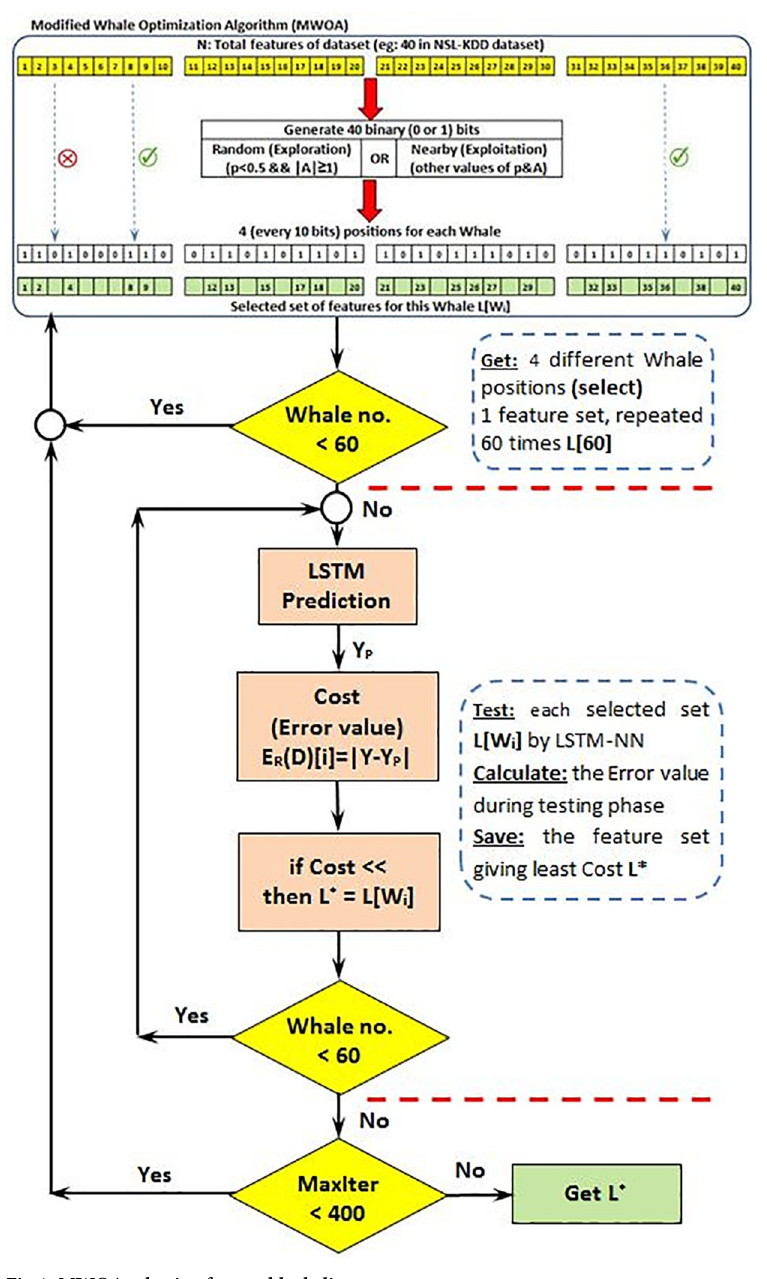
Fig 4. MWOA selecting feature block